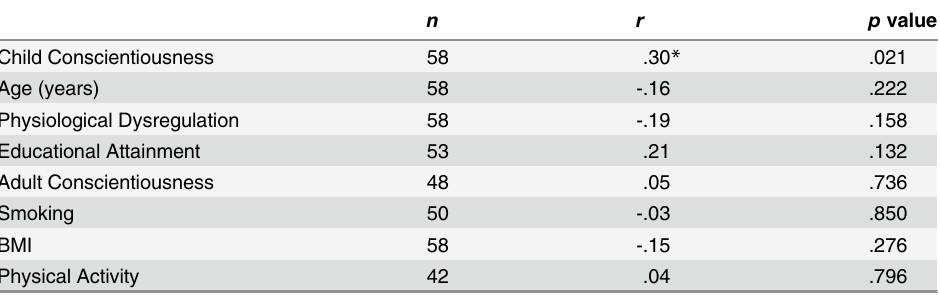
Table 2. Correlations of study variables with